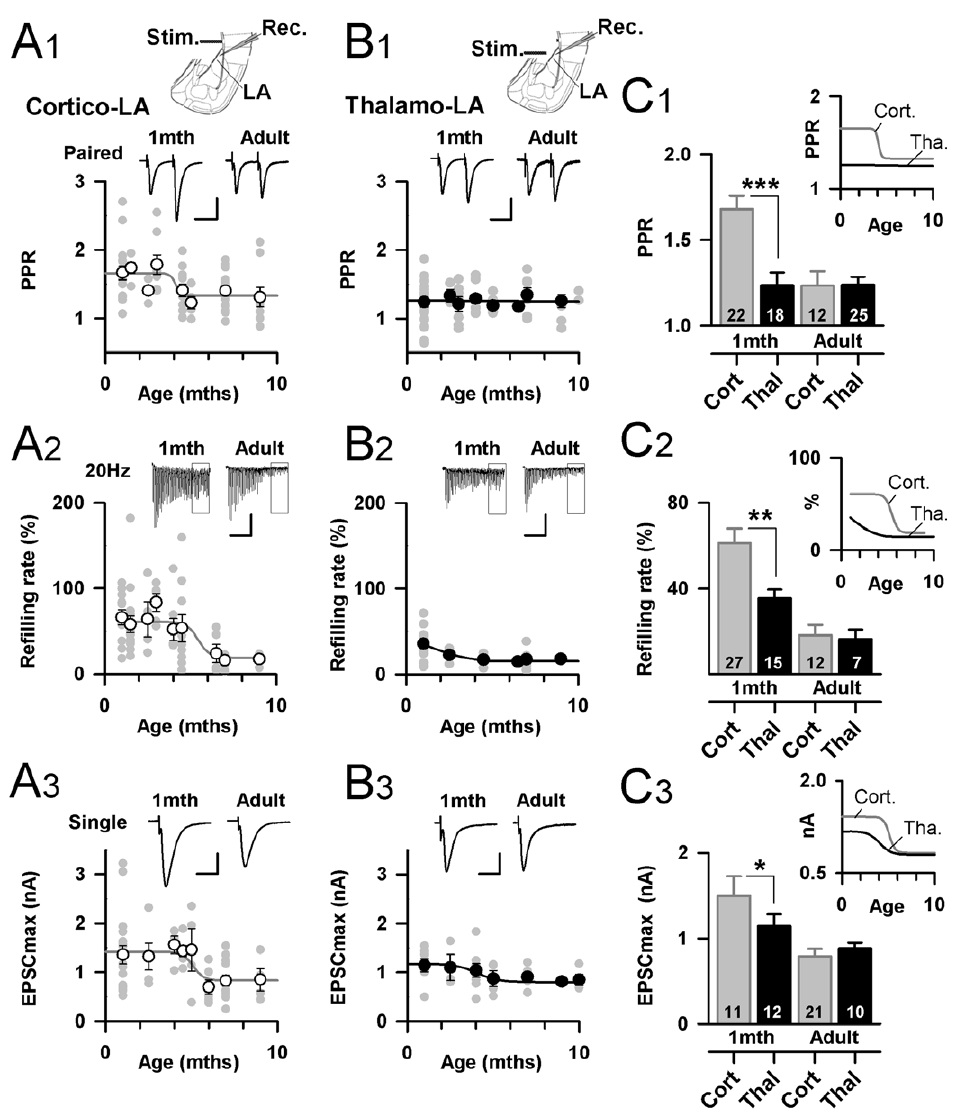
Figure 1. Synaptic maturation and elimination at excitatory projections to the LA in WT mice. A 1–3 : Developmental time course of paired pulse ratio (PPR), refilling rate and maximal EPSC (EPSCmax) at Cortico-LA synapses. Grey circles represent single experiments and white dots are mean ( 6 SEM) values at a given post-natal age. Top: typical traces. Scale bars: A 1 : 50 pA and 50 msec, A 2 : 50 pA and 0.75 sec, A 3 : 1 nA and 10 msec. A scheme of the experimental preparation is presented on top. B 1–3 : Same presentation as in A 1–3 , but for Thalamo-LA synapses. C 1–3 : Bar graphs summarizing the PPR (C 1 ), refilling rate (C 2 ) and EPSCmax (C 3 ) in juvenile (1 month) and adult ( . 6 months) WT mice. The number of recorded cells is indicated. *: p , 0.05, **: p , 0.01, ***: p , 0.001. Right: Evolution of synaptic parameters during development.